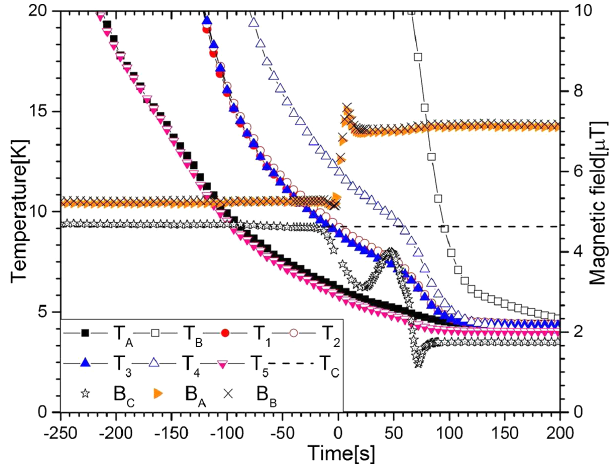
FIG. 2. Examples of measured temperatures and magnetic flux densities as functions of time during a cooldown process, where the applied magnetic field is ∼ 5 μ T. The horizontal dashed line indicates the critical temperature of Nb, T c ¼ 9 . 25 K.